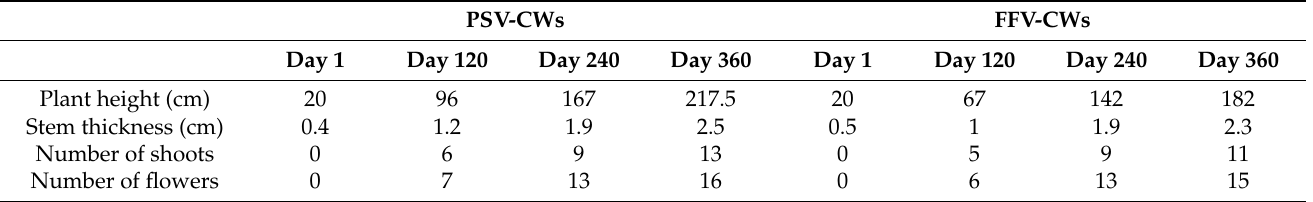
Table 3. Vegetative development of the PSV-CWS and FFV-CWS during the 12 months of